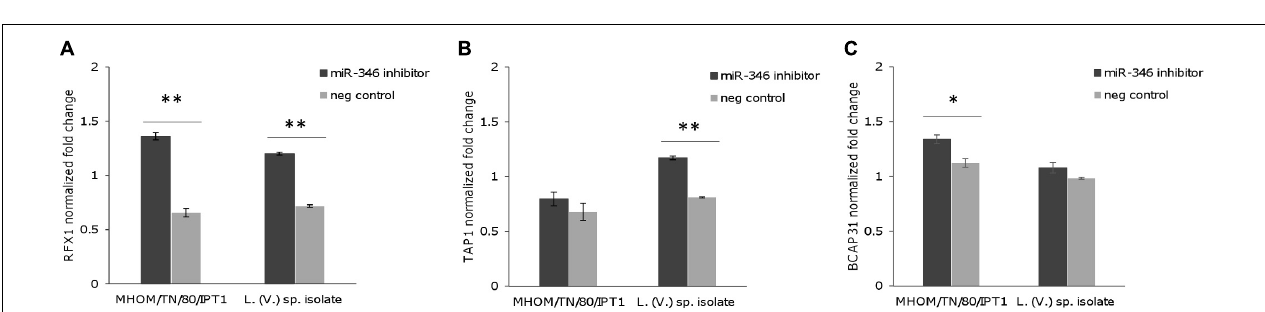
FIGURE 4 | RFX1 and IL18 are downregulated after 48 h infection with L. ( L. ) infantum and L. ( V .) sp. (A) The expression of four miR-346 predicted target genes (TAP1, BCAP31, RFX1, IL18), associated with MHC and interferon gamma production, was evaluated in THP-1-derived macrophages after 48h infection with L. ( L. ) infantum MHOM/TN/80/IPT1 strain (dark gray bars) and L. ( V. ) sp. isolate (light gray bars) ( n = 4). (B) miR-346 expression in THP-1-derived macrophages after 48 h infection with L. ( L. ) infantum MHOM/TN/80/IPT1 strain (dark gray bars) and L. ( V. ) sp. isolate (light gray bars) ( n = 4). CTR: non-infected cells. ∗ p < 0.05.